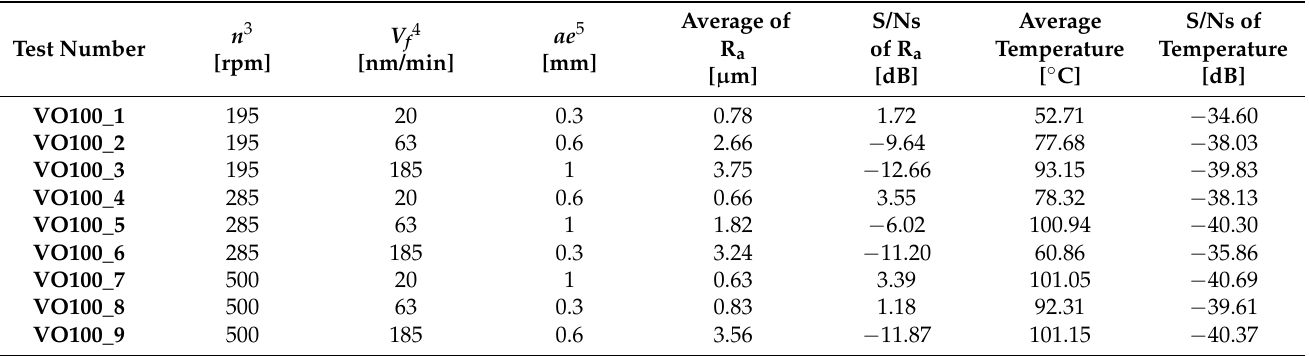
Table 10. Average surface roughness, average machining temperature, and S/Ns ratios with vegetable oil (100 mL/h).